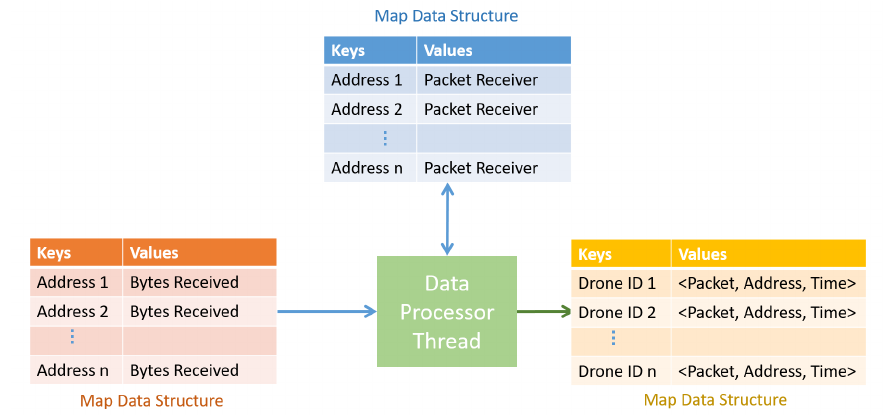
Figure 10. Operation of data processor